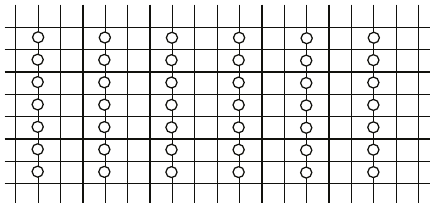
Figure 1: Control grid not aligned with the pixel grid.